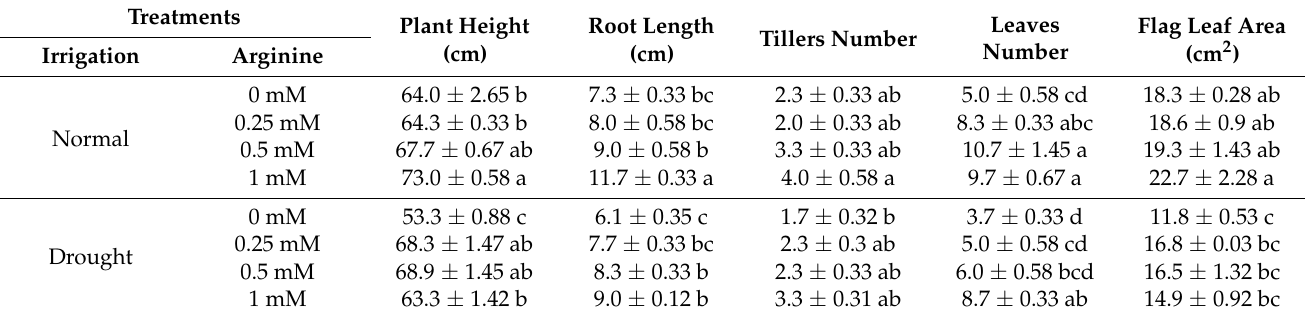
Table 1. Effect of drought, arginine application, and their interactions on plant height (cm), root length (cm), tillers number, leaves number, and flag leaf area (cm 2 ) of wheat plants. Values represent mean ± standard error. Means that do not share the same letter are significantly